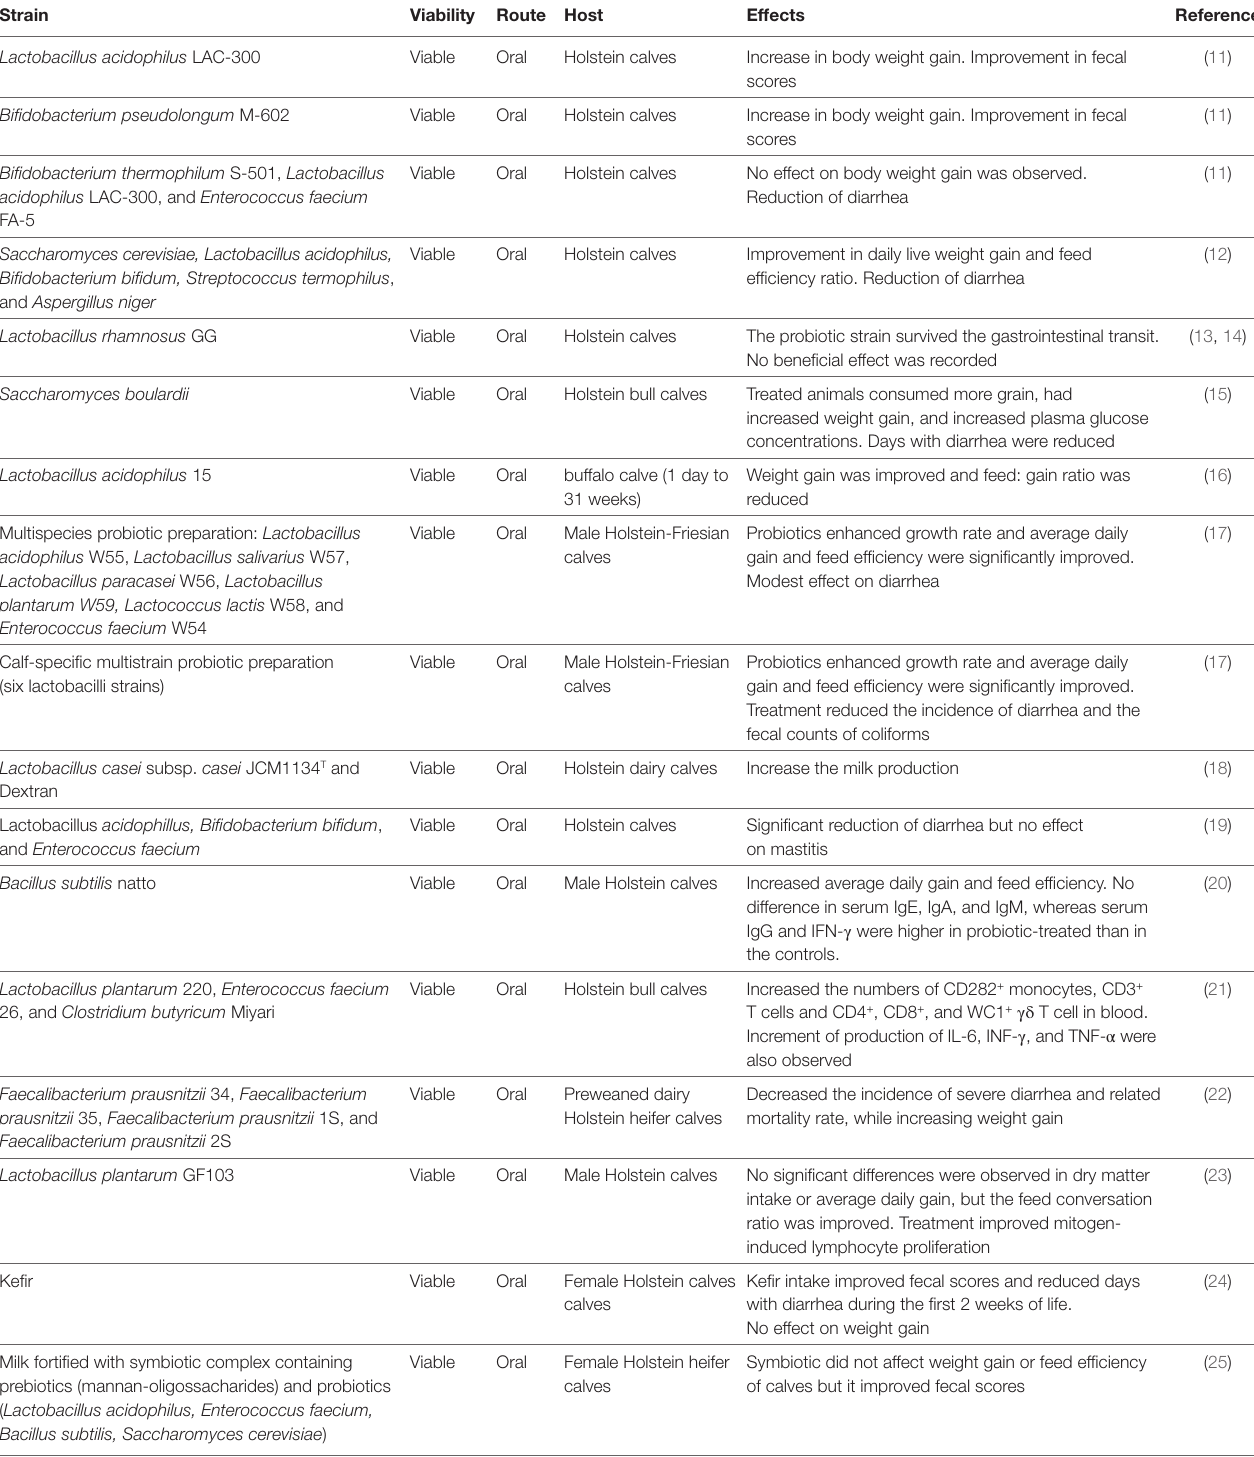
TABle 1 | Probiotics for the bovine